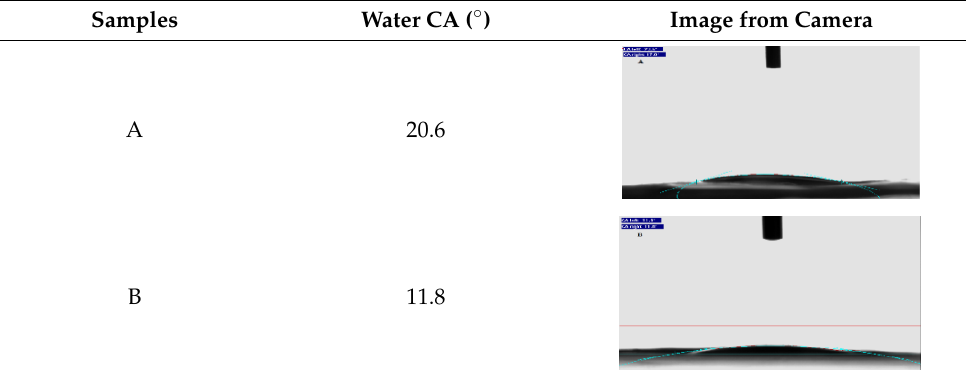
Table 3. The average water CA (°) of (A) untreated, (B) atmospheric air plasma-treated gelatin nanofibers.